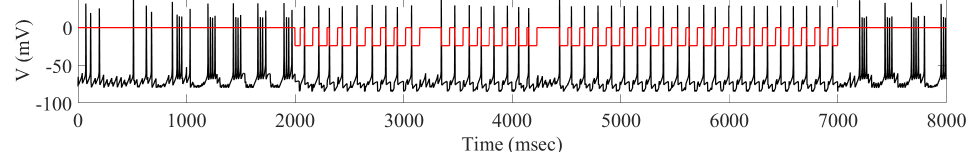
Figure 6. STN 1 membrane potential (black) with corresponding adaptive stimulation received (red) with parameters a 0 = − 24 and interspike time threshold parameter intt = 75 ms. Note that the top part of the red curve represents the time when the stimulation is turned off, while the bottom part of the curve is when the stimulation is turned